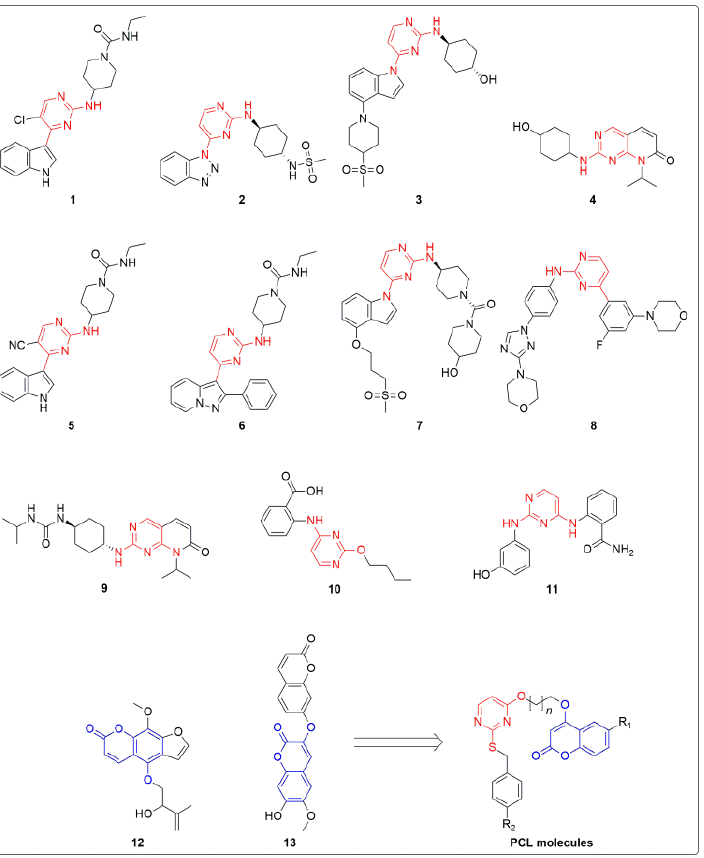
Figure 1. Evolution of newer pyrimidine-linked coumarins (PCLs) as novel chemical entities that target JNK in BC